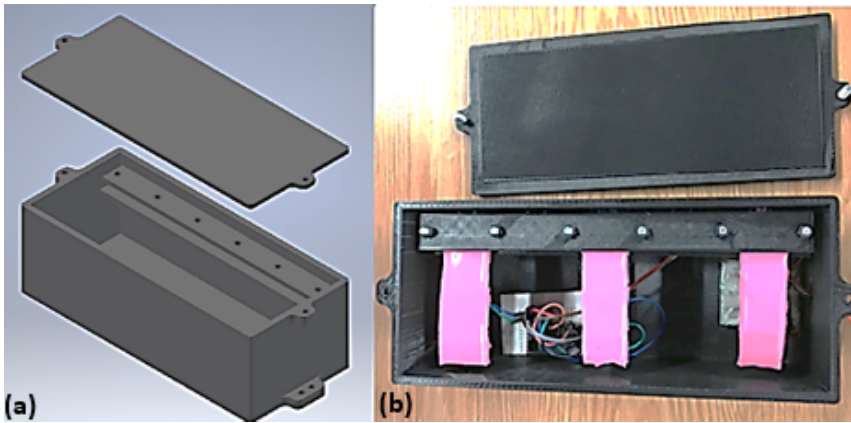
Figure 14. Energy-harvesting subsystem. ( a ) CAD drawing; ( b ) manufactured subsystem with